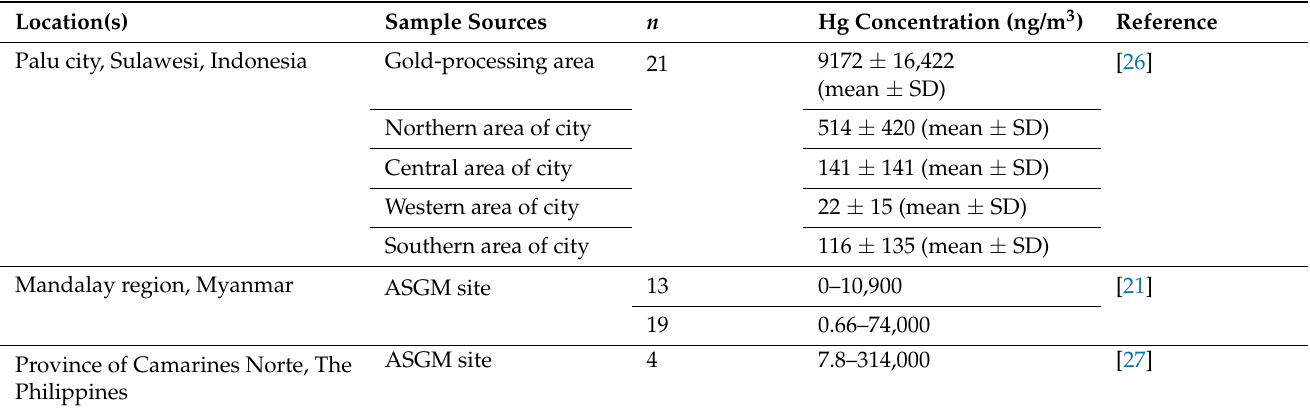
Table 3. Summary of Hg concentrations in air from Indonesia, Myanmar, and the